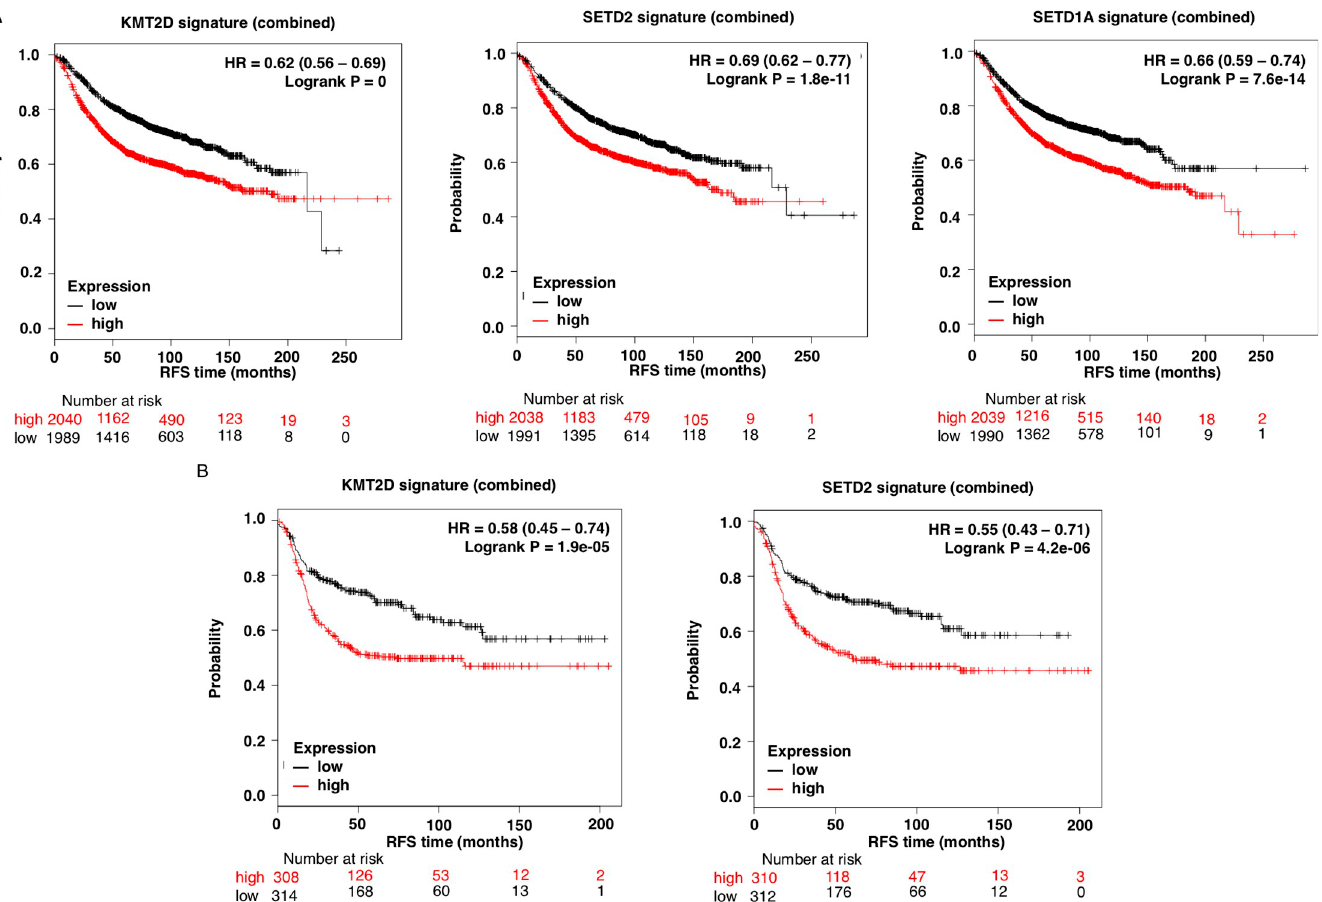
Fig 3. KMT2D , SETD2 and SETD1A mutational signature and clinical outcome. A. Association of KMT2D , SETD2 , and SETD1A mutational signature with patient outcome in all breast tumors. B. Association of KMT2D and SETD2 mutational signatures with prognosis in triple negative breast tumors. The online tool Genotype- 2-Outcome was used for both